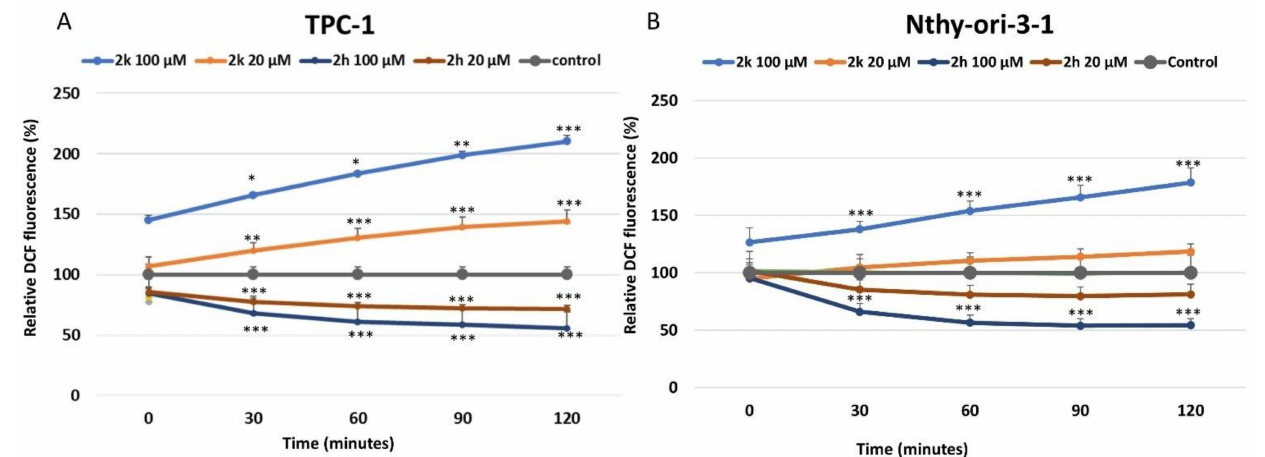
Figure 3. Effects of coumarins 2k and 2h on intracellular DCF (ROS). A and B: Graphs illustrate DCF fluorescence (ROS) levels (%) in thyroid cancer cell line TPC-1 ( A ) and thyroid normal cells Nthy-ori- 1-3 ( B ) compared with each group of control (untreated) cells. Data represent the mean ± SD of three independent experiments. Statistical analysis was performed by Student t -test. * p < 0.05; ** p < 0.01; *** p <